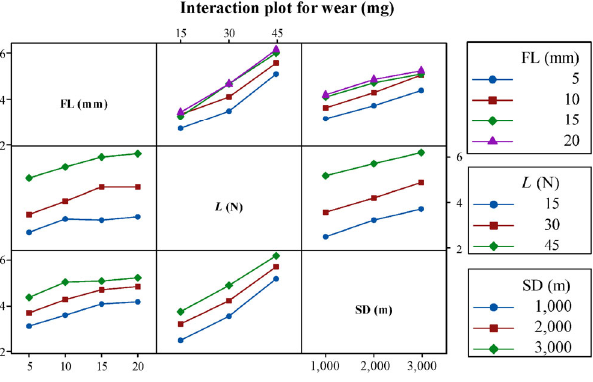
Fig. 4 Interaction plot for wear.